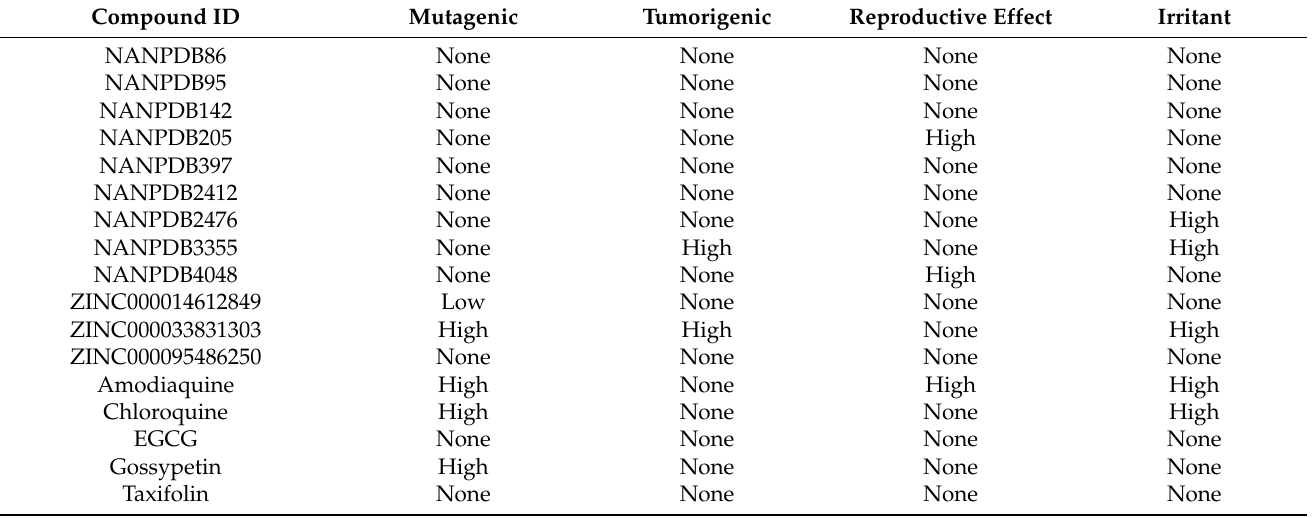
Figure 3. Percentage of inhibition activity by 12 selected compounds against the CYP450 isoforms (namely 1A2, 2C9, 2C19, 2D6 and 3A4). Majority of the compounds inhibited CYP2C9 while CYP1A2 was inhibited by none of the compounds. Table 3. Pharmacokinetic profile of the top 12 compounds and 5 known EBOV VP35 inhibitors comprising of Estimated Table 4. Toxicity profiles of selected compounds and known inhibitors. The profiles consist of mutagenicity, tumorigenicity, reproductive effect and